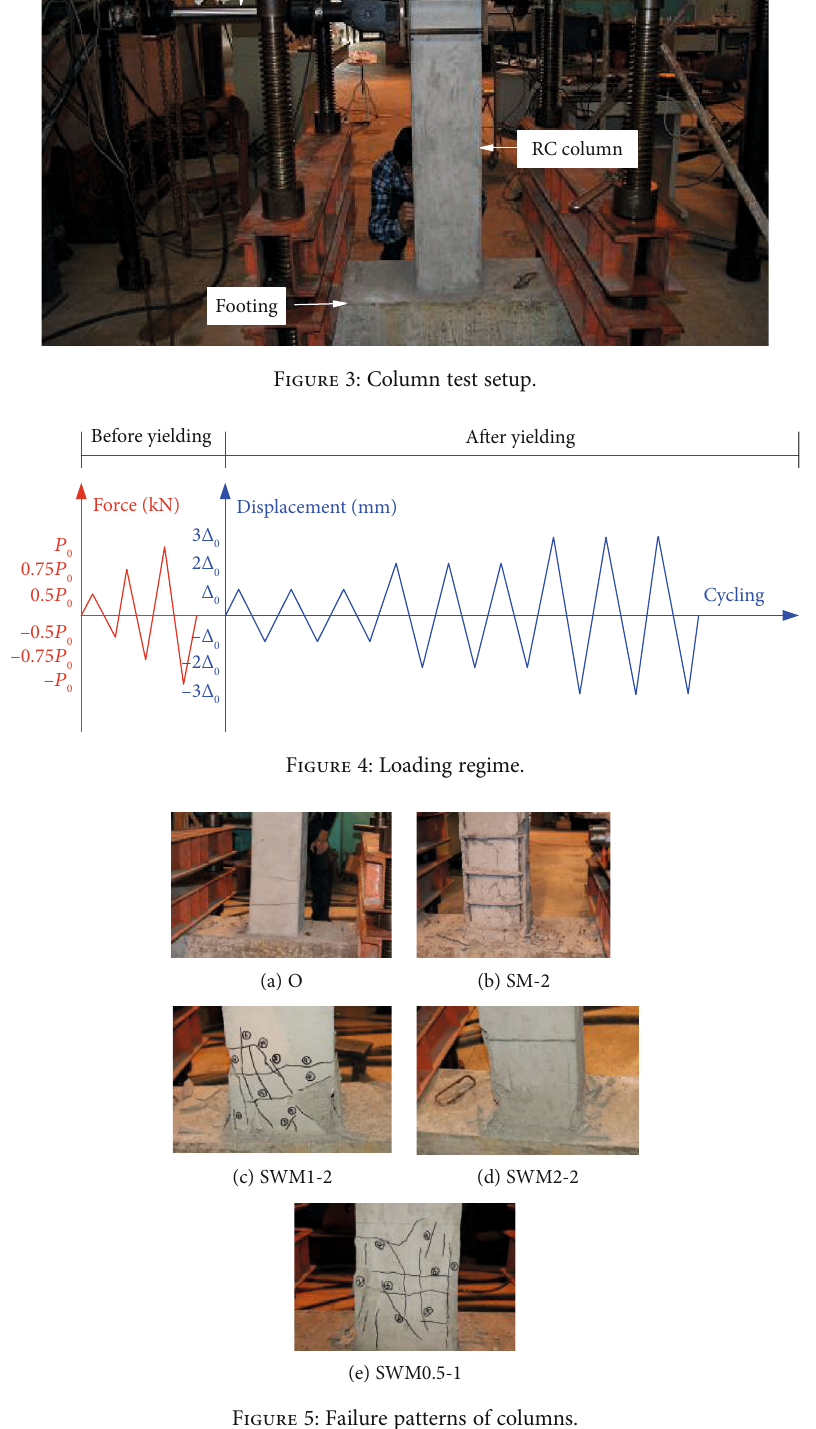
Figure 5: Failure patterns of